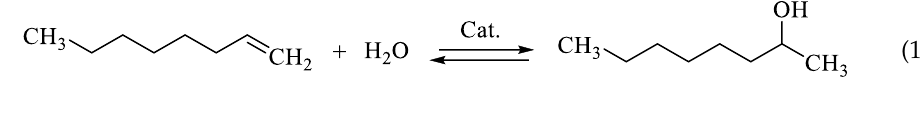
Figure 2. Experimental setup diagram. 1 — mechanical stirrer, 2 — pressure tap, 3 — thermocouple, 4 — autoclave, 5 — heating jacket, 6 — reactor controller. Octanol is produced by the liquid phase reaction of 1-octene and water in the pres- ence of a catalyst according to Equation (1).